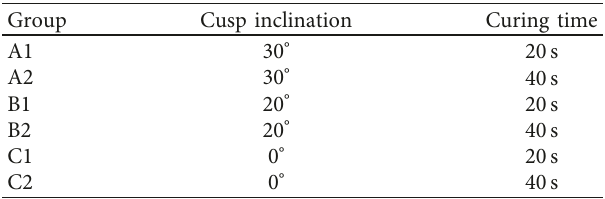
F IGURE 1: Schematic diagram of the monolithic zirconia specimen design. The length and width of monolithic zirconia were 10.0mm, and the thickness was 1.0mm. The monolithic zirconia specimen consisted of two planes: the angles between the plane and horizontal were (a) 30 ° , simulating 30 ° cusp inclination and (b) 20 ° , simulating 20 ° cusp inclination. (c) The monolithic zirconia specimen was a flat plane, simulating 0 ° cusp inclination. Table 1: Tested groups of the study.